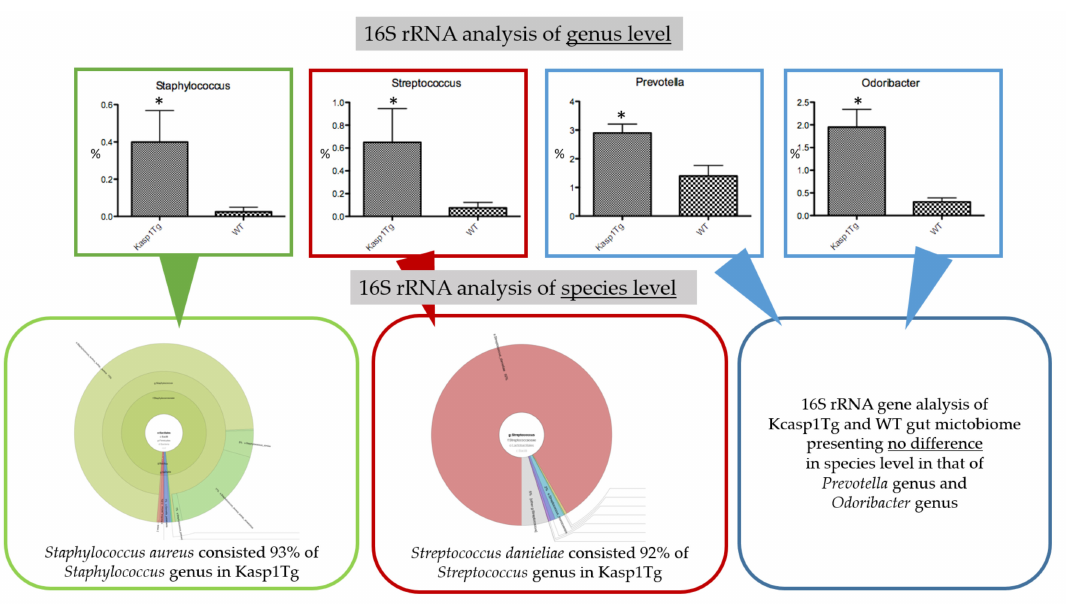
Figure 1. Analysis of 16S rRNA of the gut microbiome reveals a significant increase of the Staphylococcus , Streptococcus , Prevotella , and Odoribacter genera. * p < 0.05. All values were analyzed using